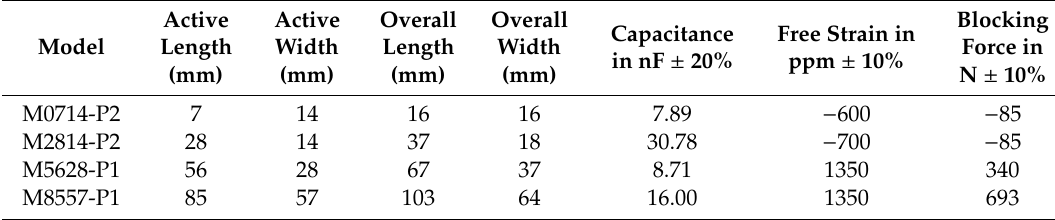
Table 1. Macro fiber composite (MFC)